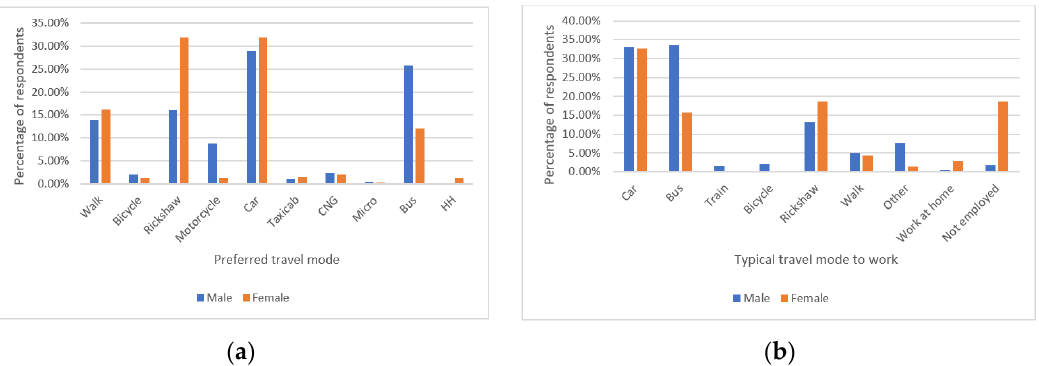
Figure 5. Gender-based comparison of ( a ) perception and ( b ) actual behavior in choosing mode to workplace.